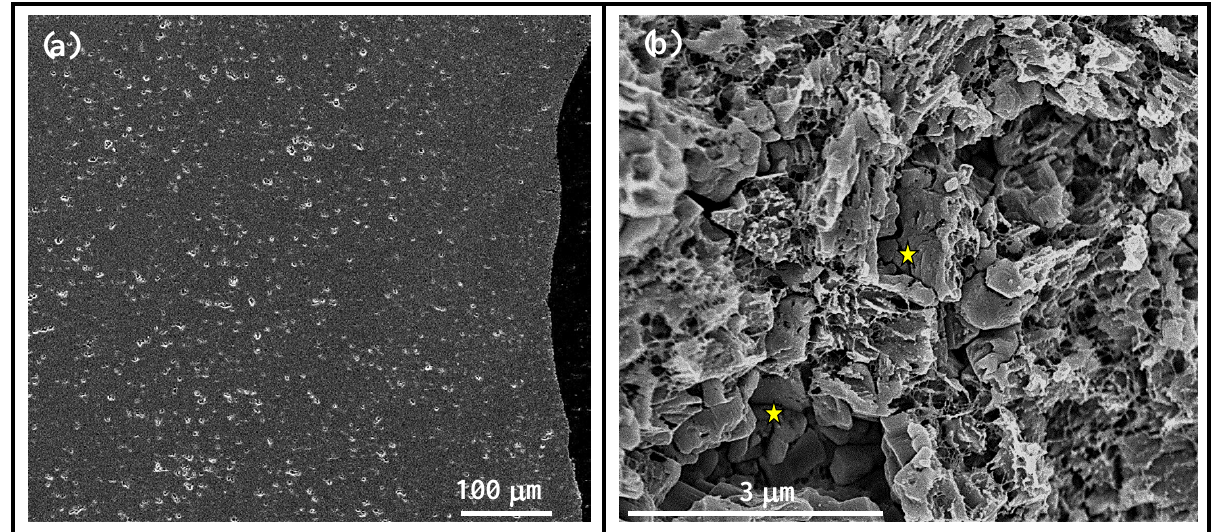
Figure A2. Accumulation of pores (whitish circular features) within the outer shell portions (a) . Yellow stars in (b) point to the location of two pores a few nanometres in